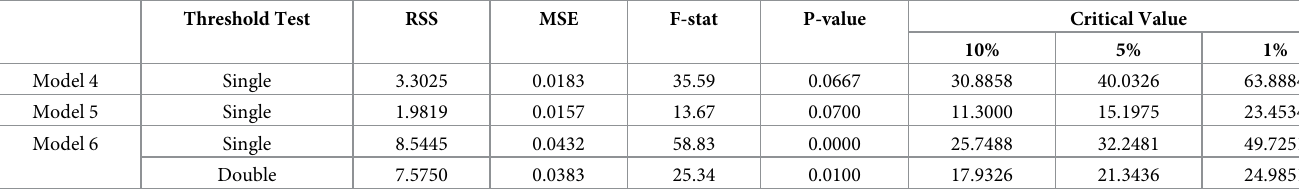
Table 14. Threshold effect existence test when LUE is threshold variable.